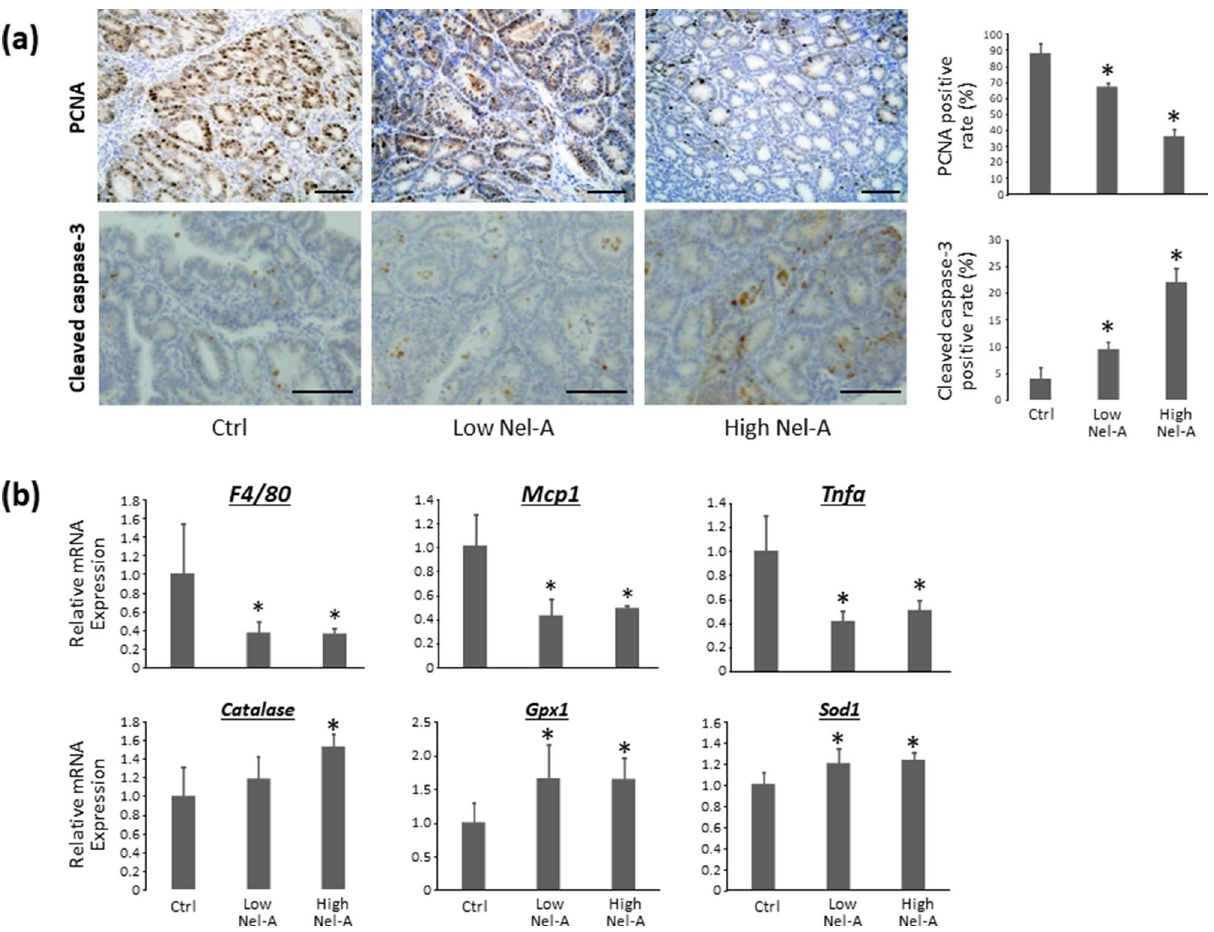
Figure 2. Effects of nelumal A on cellular proliferation and apoptosis in colorectal tumour tissues, and on inflammatory cytokines and anti-oxidant enzymes in colonic mucosa of AOM/DSS-treated mice. ( a ) Sections of the colon were stained with anti-PCNA or anti-cleaved caspase-3 antibodies. Representative photographs from each group are shown in the left panels. The positive cell indices, which were determined by counting positive cells, are shown in the right panels. ( b ) The mRNA expression levels of F4/80 , Mcp1 , Tnfa , Catalase , Gpx1 , and Sod1 in the colonic mucosa were measured by quantitative real-time reverse transcription PCR with specific primers. Parallel amplification of 18S was used as the internal control. Scale bars, 100 μm. Each column represents the mean ± SD of triplicate assays. Asterisk indicates statistically significant differences